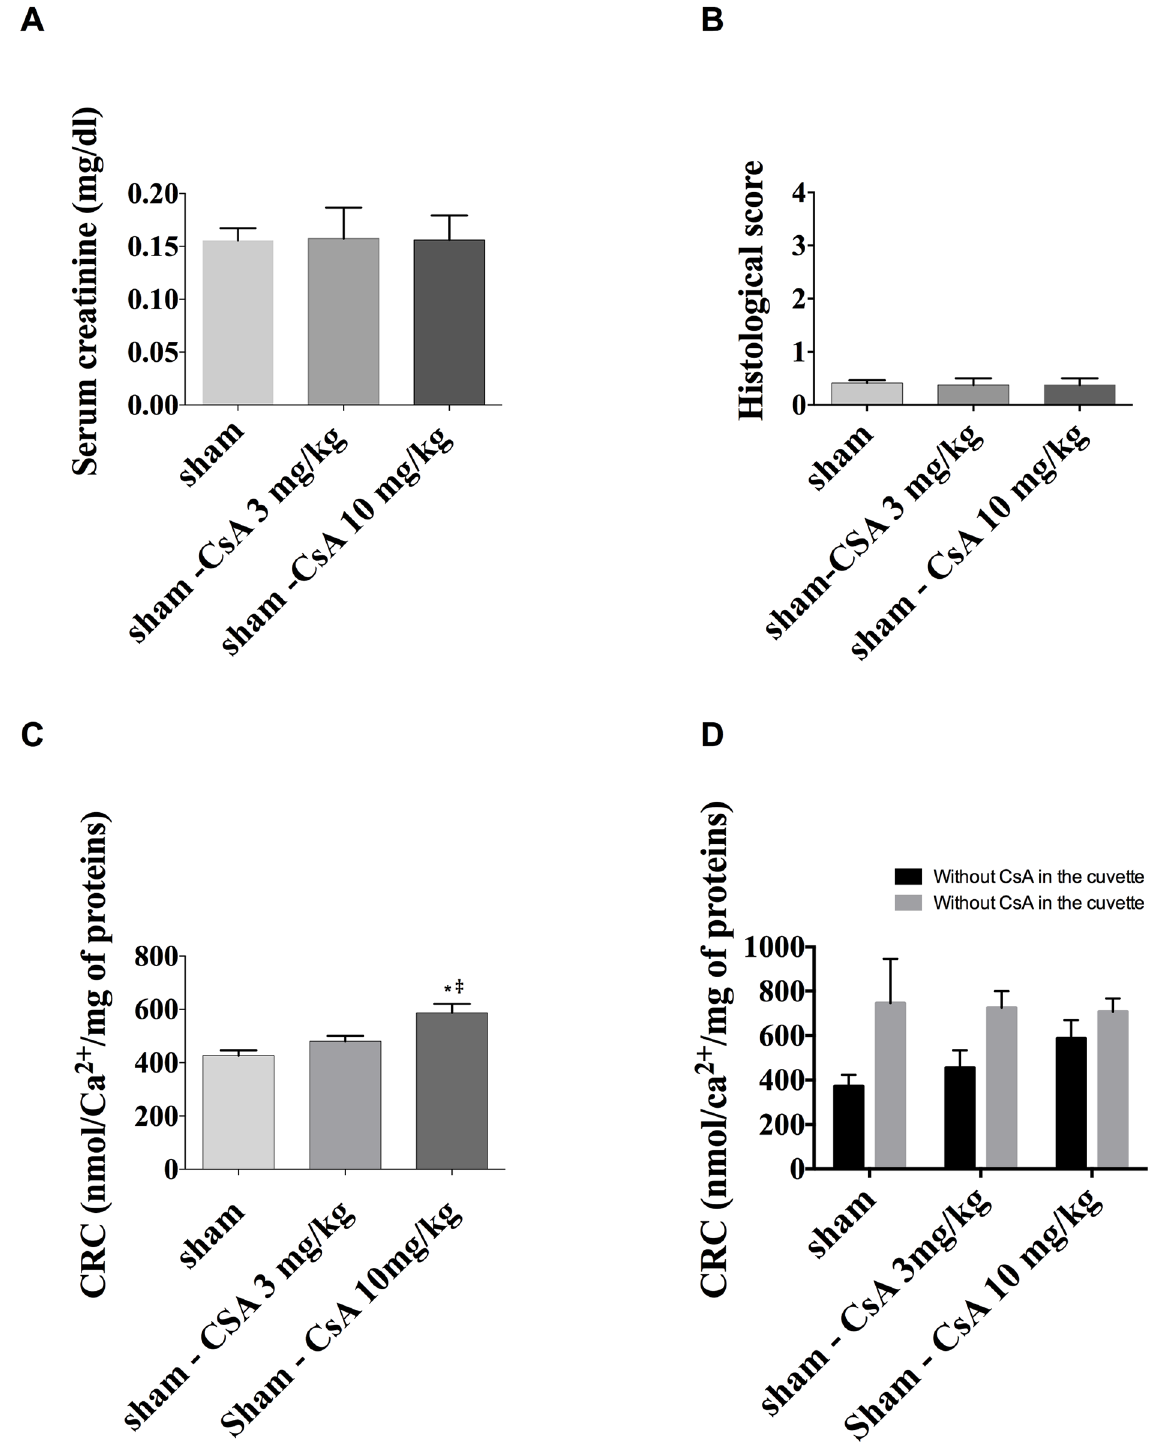
Fig 1. (A) Serum creatinine levels, (B) histological scores and (C) calcium retention capacity of CsA-treated and untreatedsham mice after 24 h of reperfusionfollowingrenal ischemia. The three groupsonly differ in terms of their calcium retention capacity, which is significantly higherin the group that was given 10 mg/kg CsA than in the mice that were given a 3 mg/kg dose. D. Effect of addition of CsA directly into the cuvette on Calcium Retentioncapacity. Additionof CsA directly on mitochondria increasedCRC in all groups.